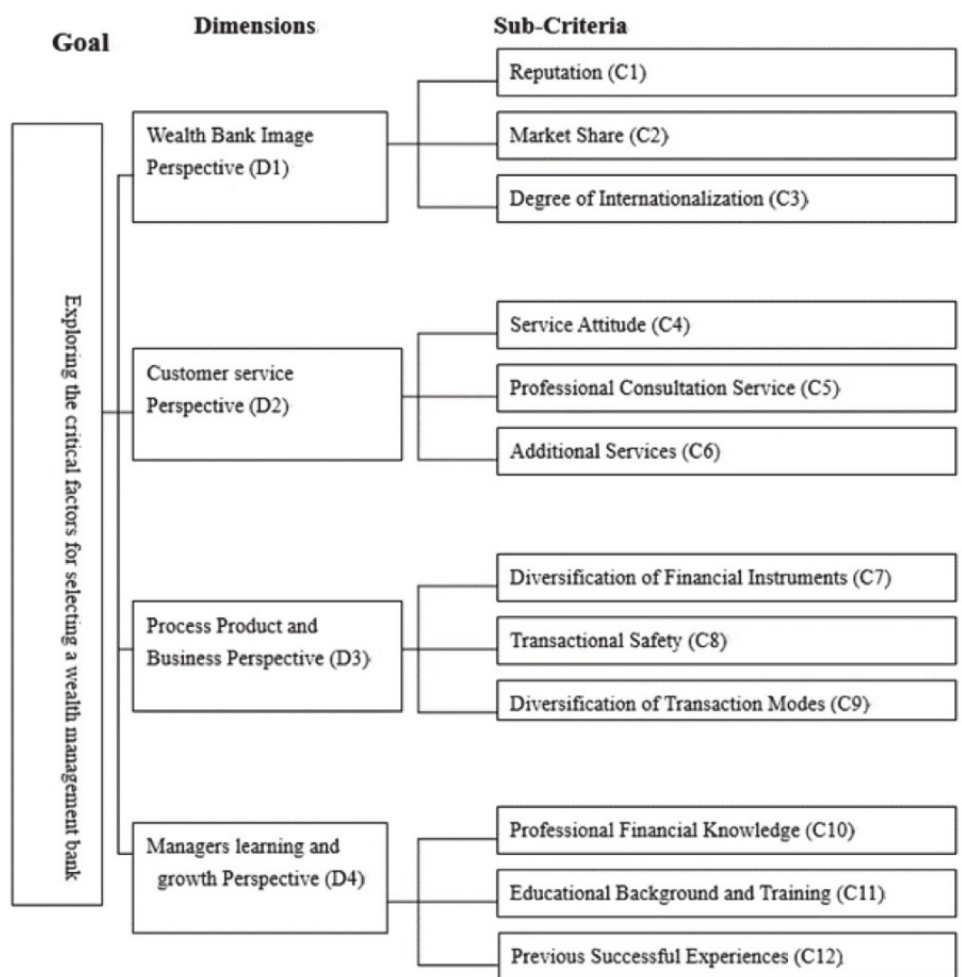
Figure 1. Evaluation framework for wealth management banks .